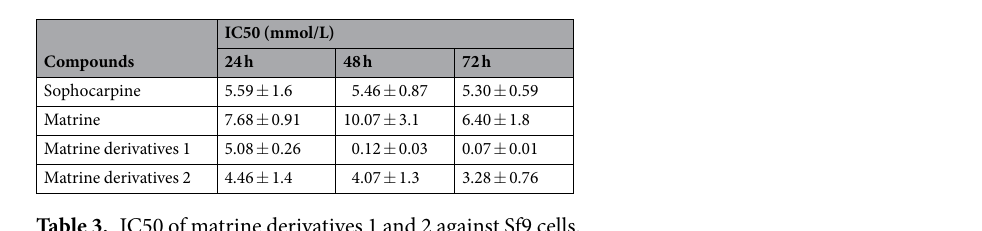
Table 3. IC50 of matrine derivatives 1 and 2 against Sf9